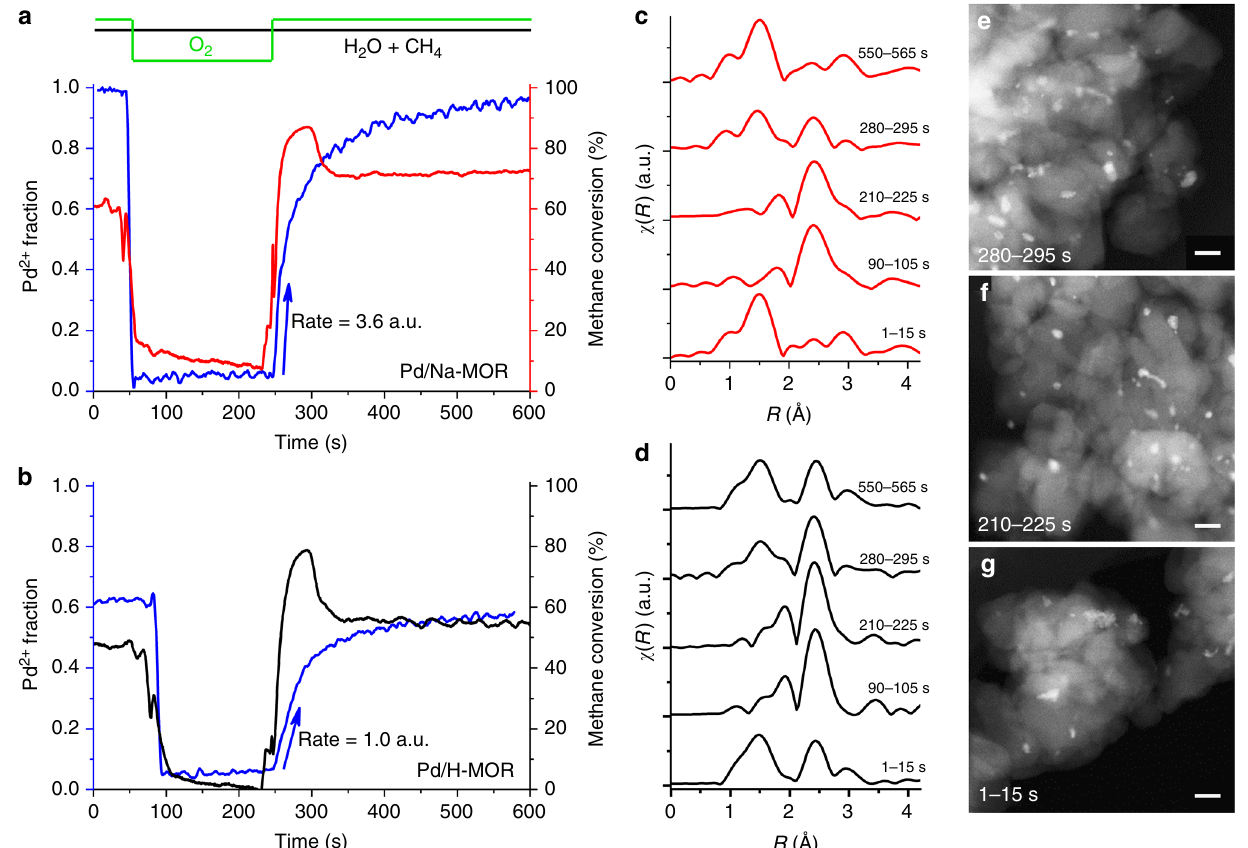
Fig. 4 Transient operando EXAFS experiment with oxygen cut-off. a , b Fraction of oxidized palladium in Pd/Na-MOR and Pd/H-MOR and corresponding catalytic activity in 1 vol% CH 4 , 4 vol% O 2 , 5 vol% H 2 O, bal. N 2 , GHSV = 350,000 h − 1 at 350 °C. Oxygen was removed from the feed to perform reduction of palladium by methane and then added for subsequent reoxidation in reaction conditions. c , d Fourier transforms of in situ Pd K-edge EXAFS spectra (non-phase shift corrected) of Pd/Na-MOR and Pd/H-MOR upon averaging 15 spectra at 1, 90, 210, 280, and 550 s of the experiment. Corresponding coordination numbers are given in Table 2. Initial rates were obtained from fi tting the linear function over the fi rst 10 points during reoxidation. e , f , g STEM images of the quenched Pd/H-MOR at 1, 210, and 280 s. Scale bar: 20